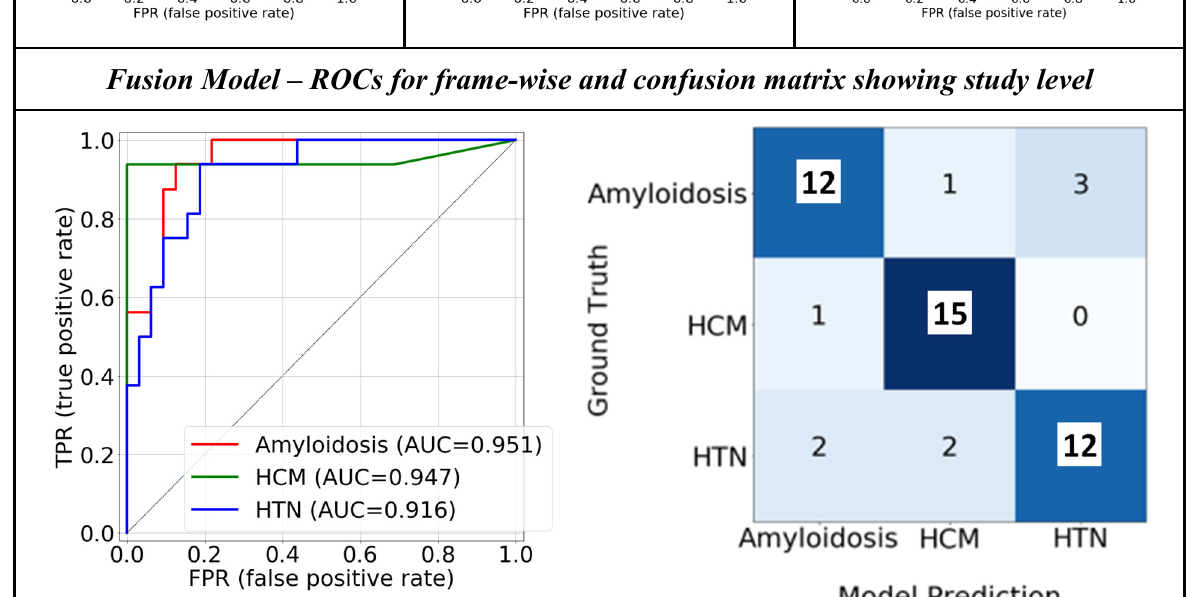
Figure 3. Class-wise ROC plots show the quantitative performance of the view-dependent models and final fusion model. The confusion matrix of the fusion model is also displayed. ‘Others’ category is referred to as ‘HTN.’.